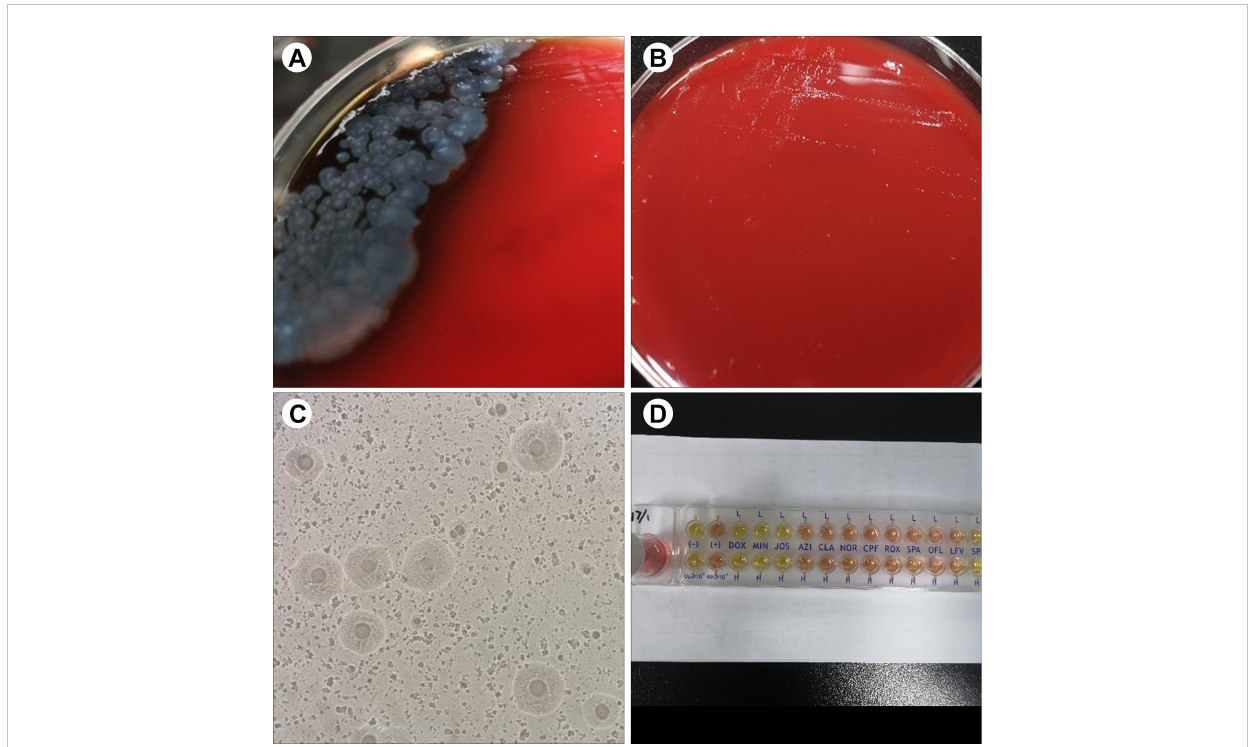
FIGURE 1 Representative results of sample culture and antibiotic susceptibility testing in patients. (A) On day 14, P. aeruginosa was positive in the blood culture and bacterial culture of wound tissues. (B) On day 28, tiny, nonhemolytic, and transparent colonies were observed on the Columbia blood agar plate. (C) Fried-egg-type colonies were observed on mycoplasma medium after 5 days of incubation. (D) The results of antibiotic susceptibility testing showed that M. hominis was susceptible to doxycycline, minocycline, and josamycin but resistant to azithromycin, clarithromycin,